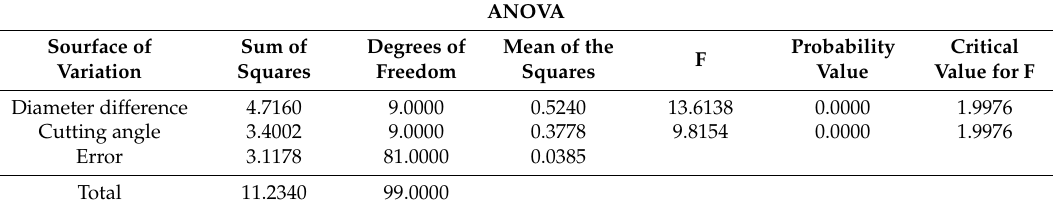
Table 2. Combined influence of the cutting angle and the difference betwen diameters in graft success. All statistical analyzes were done using a significance factor of 95% ( p ≤ 0.05). ANOVA summary tables (1 dmm is a tenths of a millimeter, 10 − 4 m). The result of the analysis ANOVA (two factors without replication) indicates that the statistical value of “F” is much higher than the critical value for “F” for both factors: angles and differences between diameters. Therefore, we can assure that the results of our tests are significant.